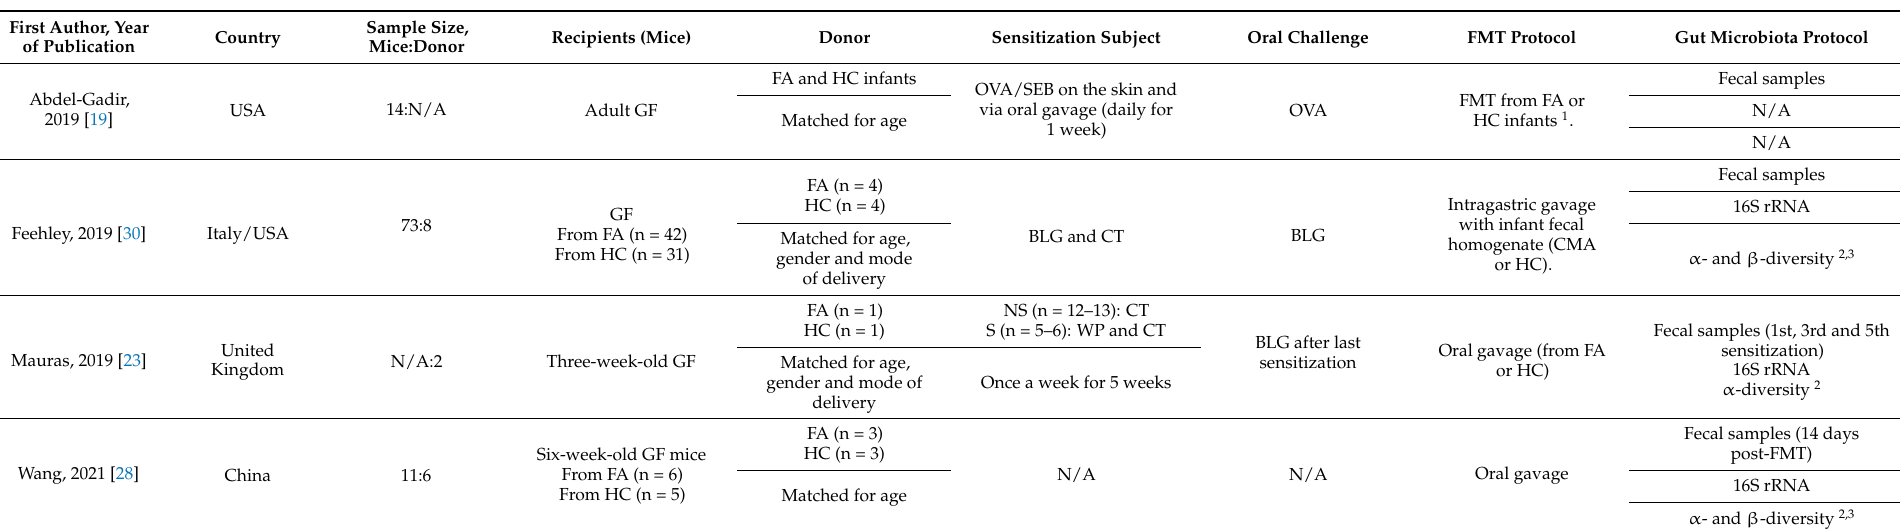
Table 3. Characteristics of studies exploring fecal microbiota transplantation (FMT) in mice from human